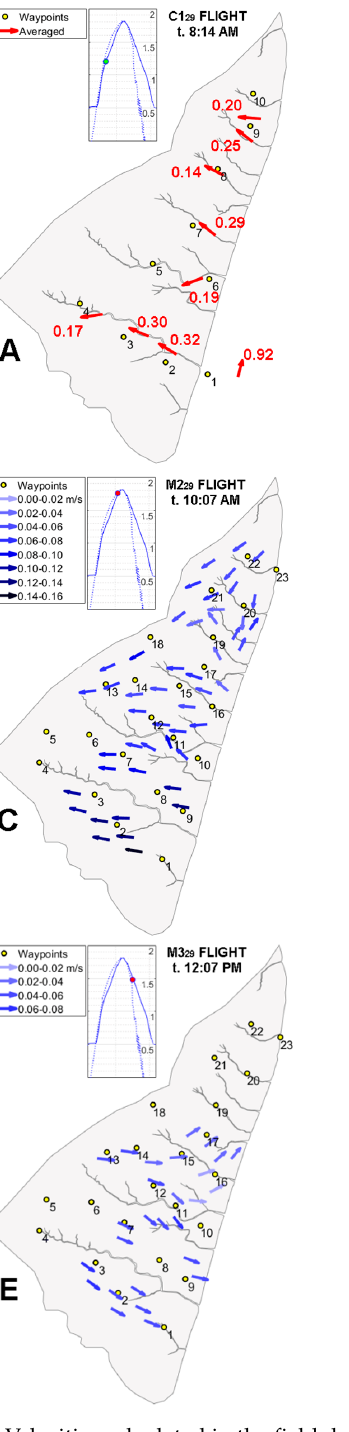
Figure 10. Velocities calculated in the field during the flights for the survey performed on the 29th of October. The blue arrows describe the velocities calculated from the dye clouds, interpolated over the marsh for the M 29 flights, and instantaneous for the C 29 flights. The red arrows are the average velocities in each waypoint, described by numbered yellow dots. The dots (red for the marsh, green for the creeks) represent the reported central time of the UAV survey. The subfigures show the flow field for: ( A ) The first flight over the channels (C1 29 ); ( B ) The first flight over the marsh (M1 29 ); ( C ) The second flight over the marsh (M2 29 ); ( D ) The second flight over the channels (C2 29 ); ( E ) The third flight over the marsh (M3 29 ); ( F ) The third flight over the channels (C3 29 ).